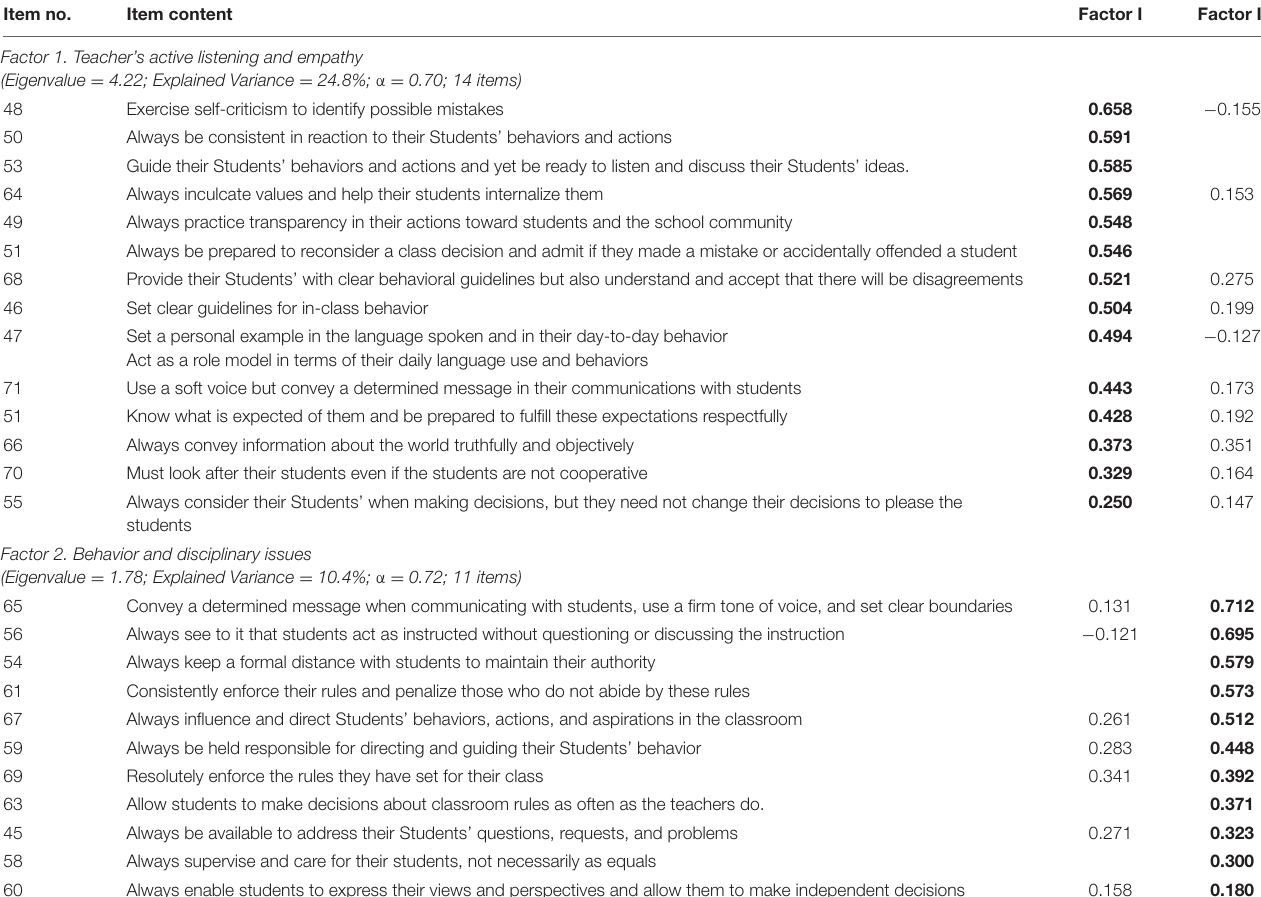
TABLE 3 | The scale of parents’ perceptions of the concept of “teacher’s authority.” Item